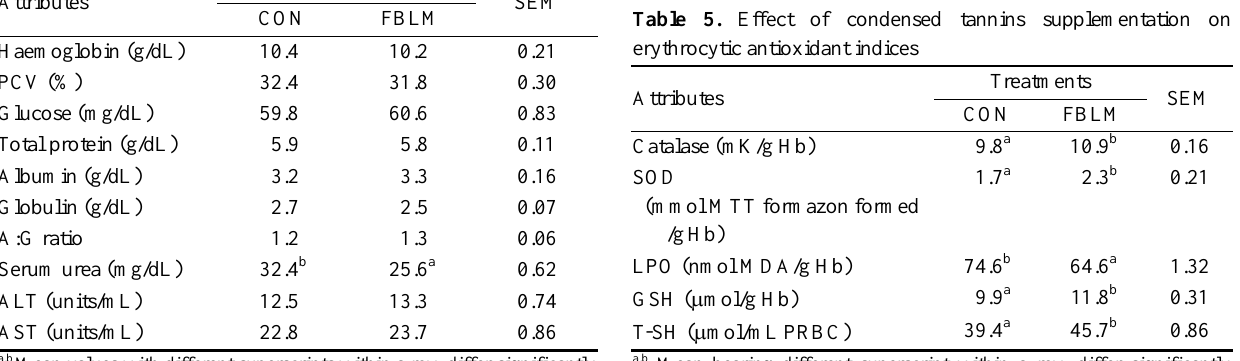
Table 4. Effect of dietary inclusion of condensed tannins through Ficus bengalensis leaves on hemato-biochemical parameters of crossbred cows Treatments Attributes Table 5. Effect of condensed tannins supplementation